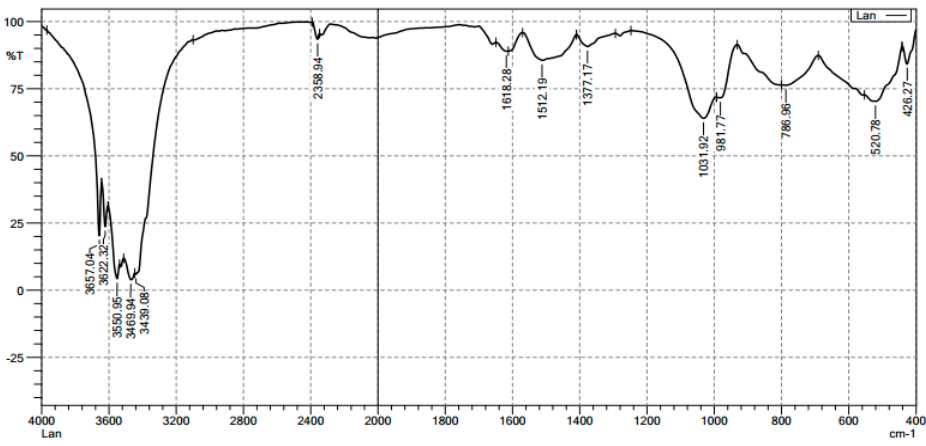
Figure 3. The FT-IR spectra of synthesized γ -Al 2 O 3 nanoparticles.